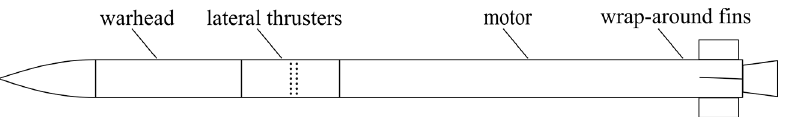
Figure 1. Configuration of the 160 mm